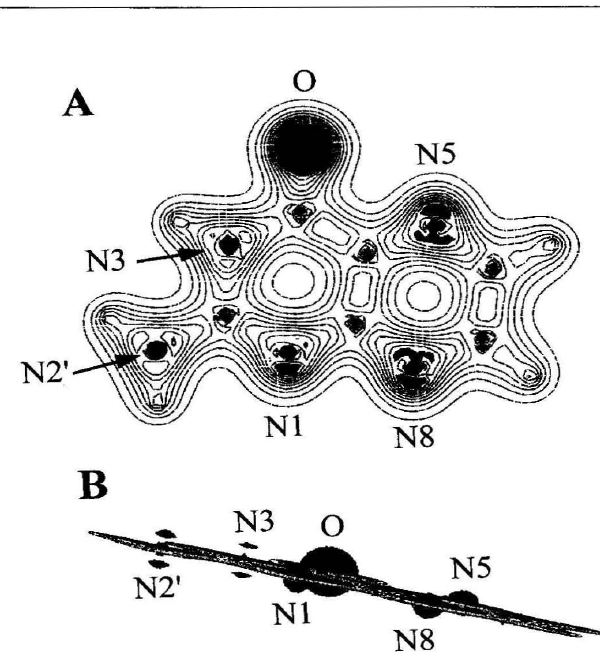
figure 1. Contour and isodensity plot of electronic char ge density of pterin. Contour levels are from 0.05 a.u. (outermost isoline) to 0.50 a.u. in steps of 0 .05 a.u. Also shown is the isodensity surface at a value of 0.54 a.L1. showing specifically the differences at the various nitro gen atoms. A) View from above the molecular plane; B) fi'ont